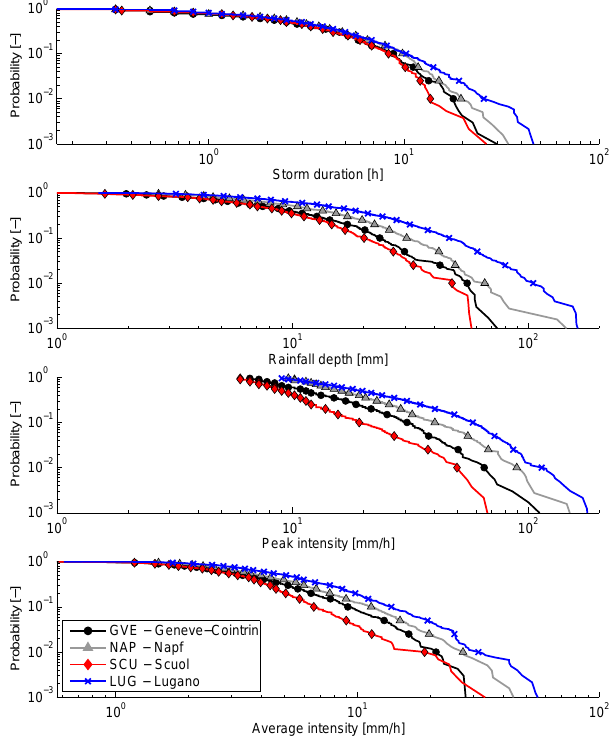
Fig. 10. Cumulative distributions (exceedance probability) of main storm properties for intense warm season storms: storm duration D , total rainfall depth R , peak intensity I p and average storm intensity I a (from top to bottom) at the studied stations.